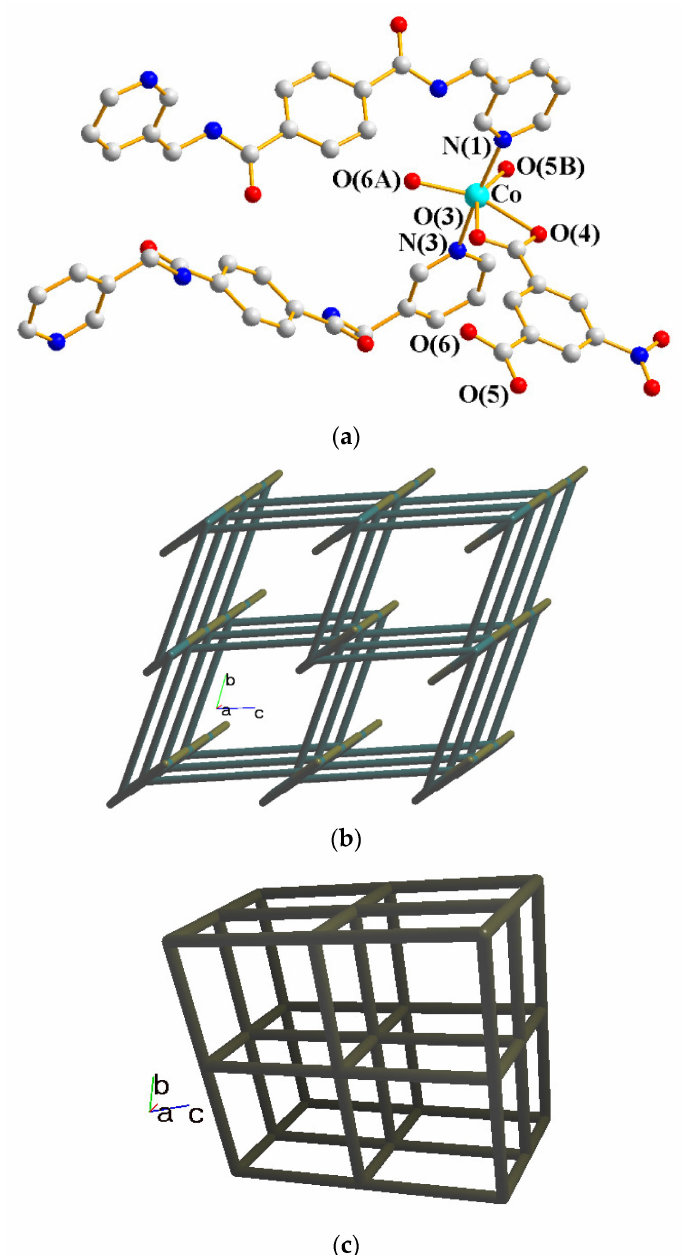
Figure 3. ( a ) Coordination environment of the Co(II) ion in 2 . Symmetry transformations: (A) − x + 1, − y, − z; (B) x + 1, y, z. ( b ) A drawing showing the 3,5T1 topology. ( c ) A drawing showing the pcu